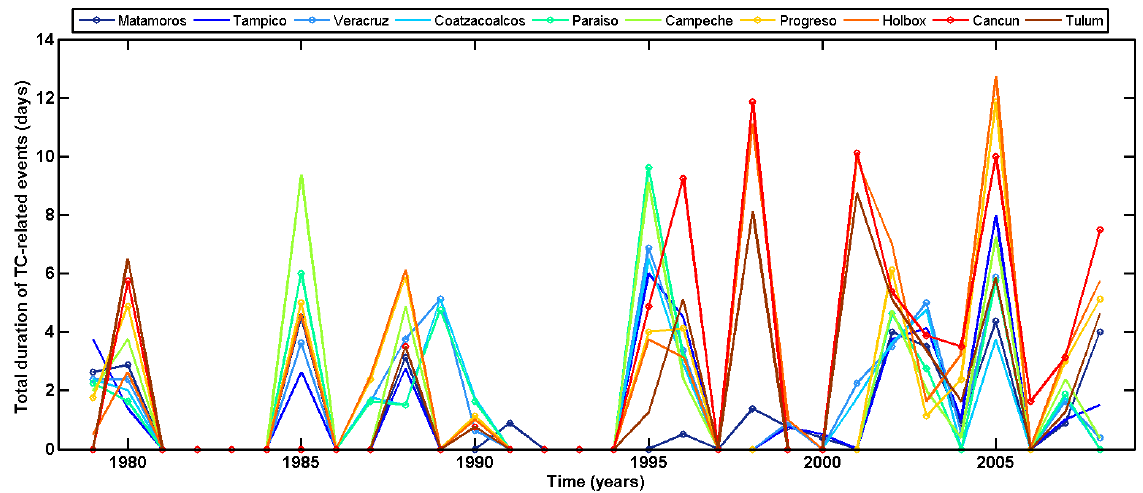
Figure 9. Total amount of time (in days) with TC-related storm conditions per season.